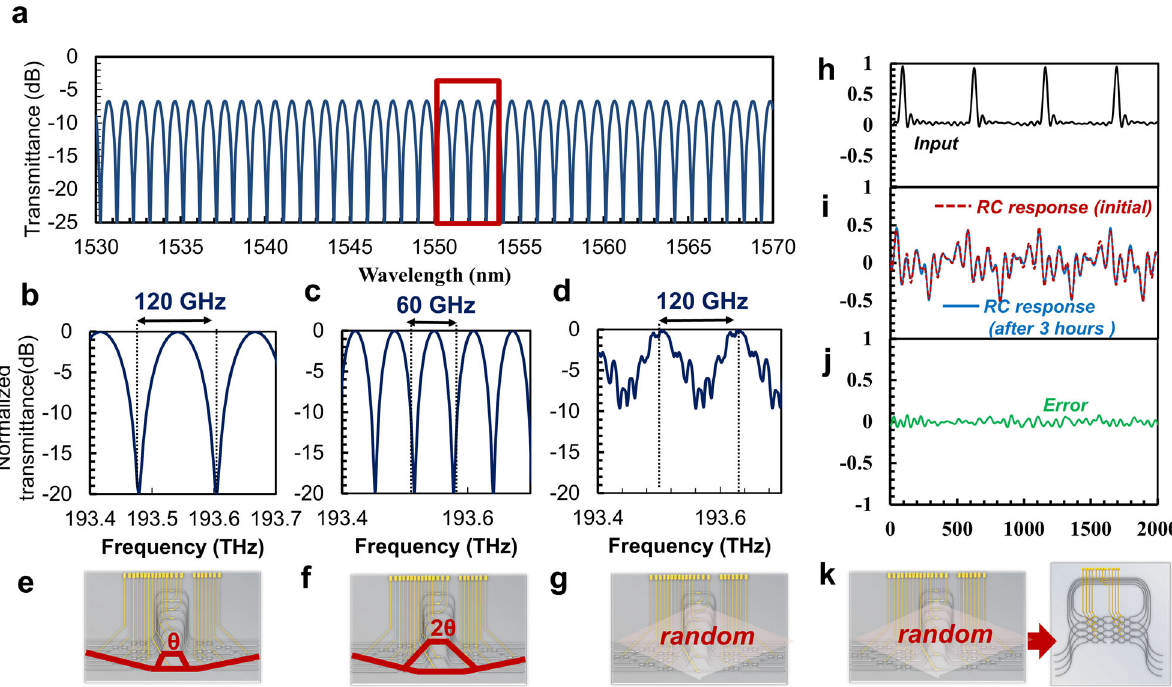
Fig. 3 Frequency and time response of fabricated circuit. a Experimentally obtained wavelength (frequency) fi ltering shape of the fabricated input mask circuit for the center output port (number 16) over the wavelength range of 1530 – 1565 nm. The delay difference was set to θ . b Magni fi ed view for a . c , d Filtering shape with c delay difference of 2 θ and d randomly set input mask. e – g Setting state of input mask circuit with e delay difference of θ [for a and b ], f 2 θ [for c ], and g random state [for d ]. The observed frequency response suggests the accurate implementation of input mask circuit. We also examined the time domain response and the stability of the fabricated chip by inputting the masked signal into the center coherent cavity (number 8). h – j , h Input pulse and i time responses of reservoir computer before and after 3-h operation and j their error. k Setting state of input mask and reservoir circuit [for h – j ]. Thanks to the solid-state circuit technology, the reservoir response for the fabricated circuit is stable over a period of three hours without any feedback operation, which is enough time to execute most RC